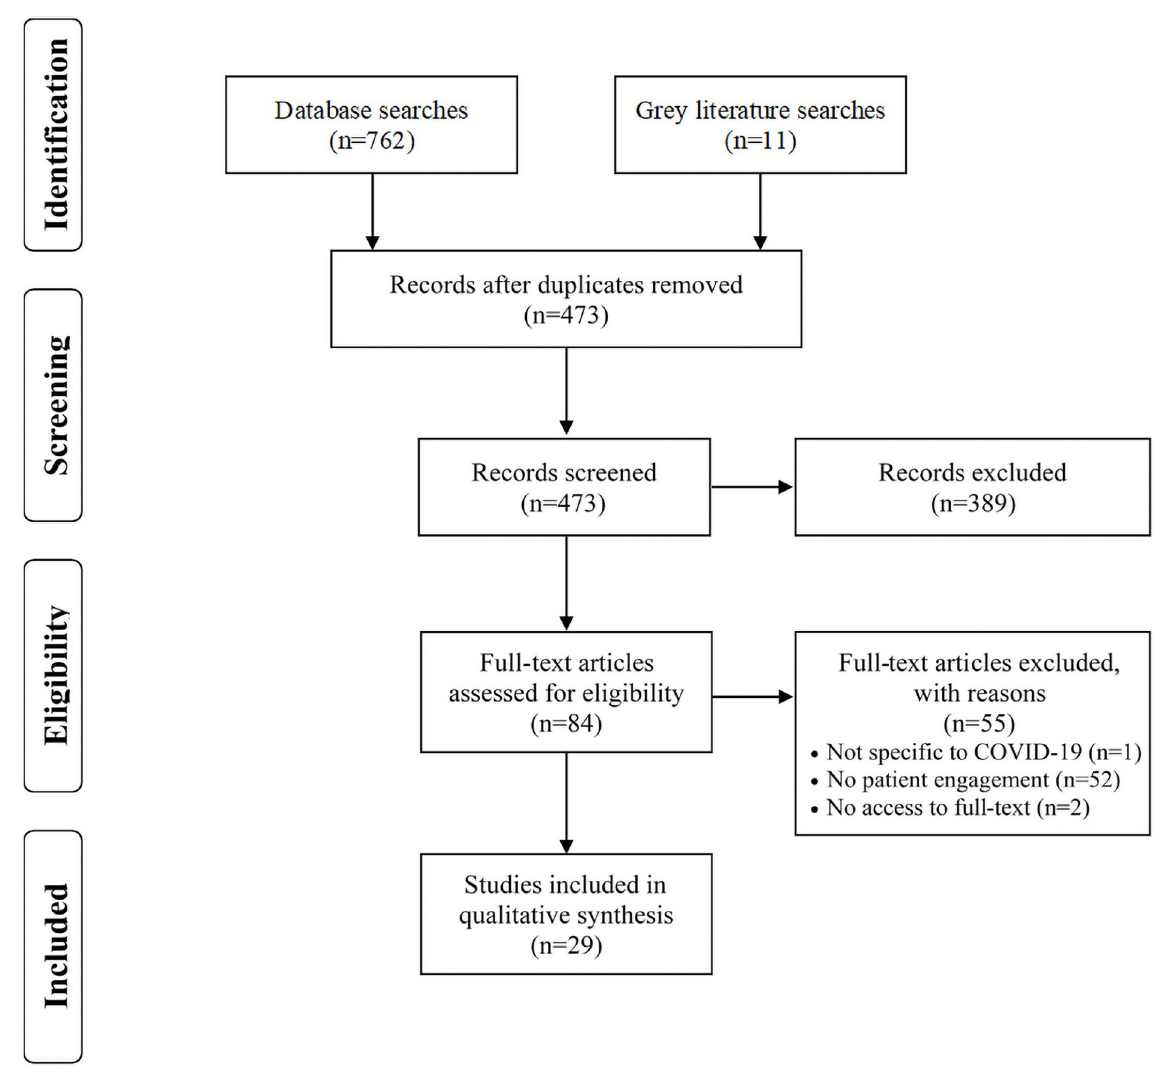
Fig 1. PRISMA flow diagram of included